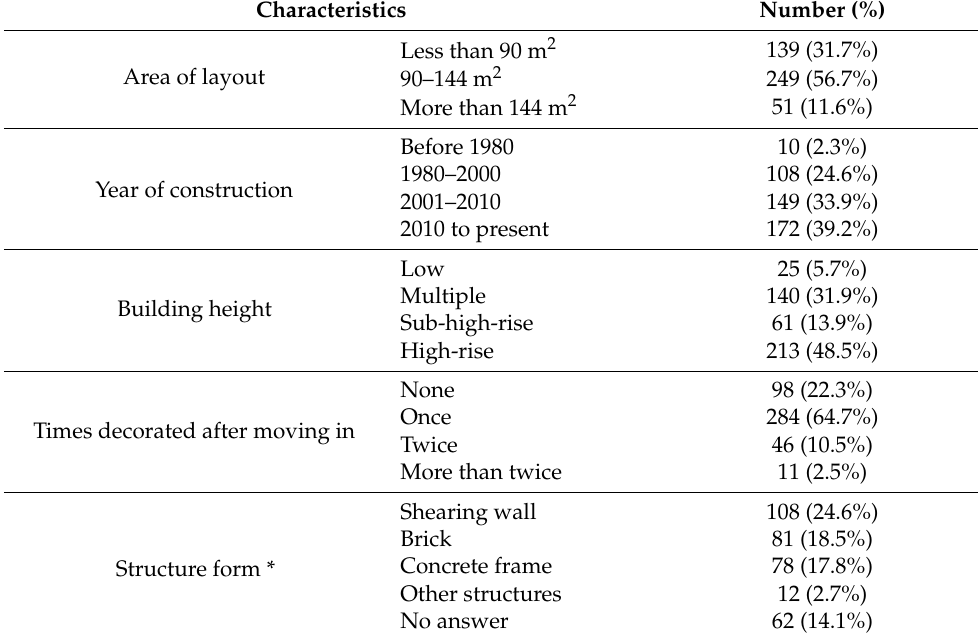
Table 3. Characteristics of the respondents’